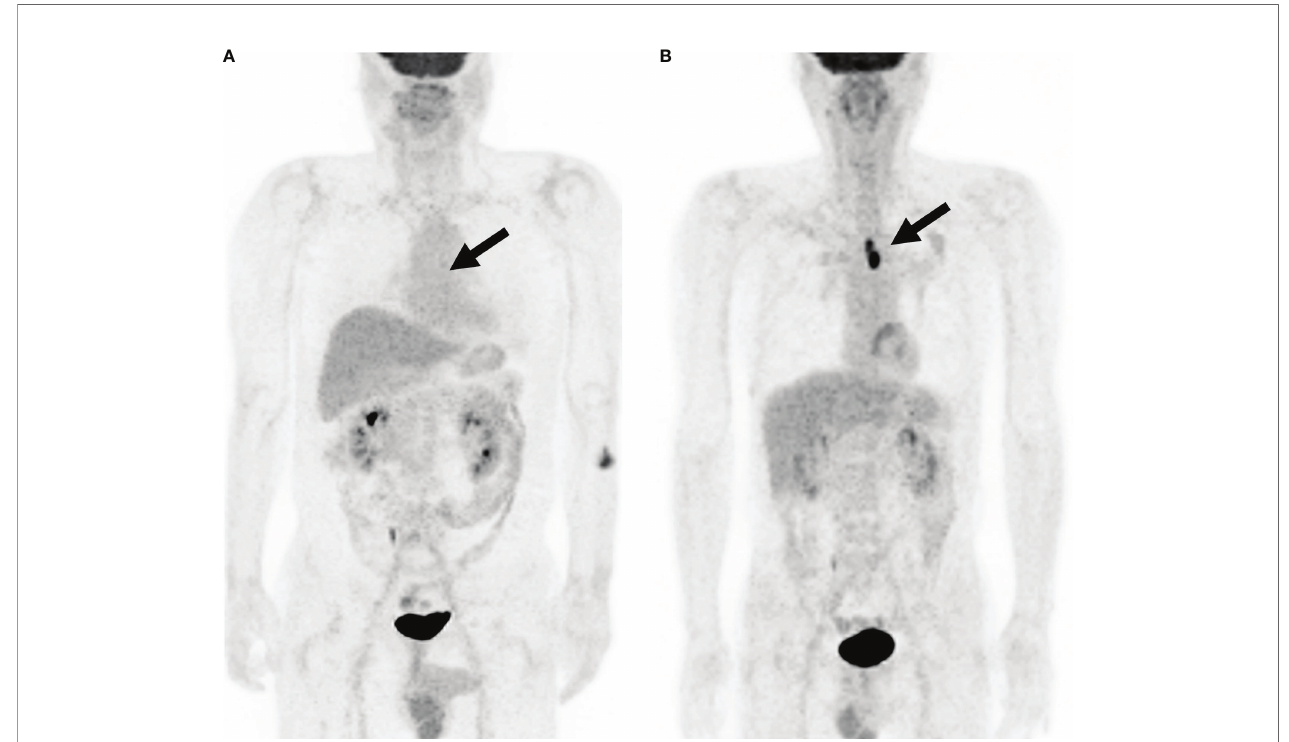
FIGURE 5 | Representative cases of upstaging and downstaging according to SUVmax Maximal intensity projection images of FDG PET/CT demonstrate representative cases of upstaging and downstaging. (A) A 73-year-old male patient with ht low SUVmax of 1.0 (red arrow). Thus, he was downstaged into the new proposed stage I. DFS duration was 1,554 days, and OS duration was 2,546 days. (B) A 75-year-old male patient with esophageal SqCC of stage I. The tumor was clearly demonstrated in the image due to its high SUVmax of 16.0 (red arrow). Thus, he was upstaged into the new proposed stage II ( Figure 5b ). DFS duration was 329 days, and OS duration was 496